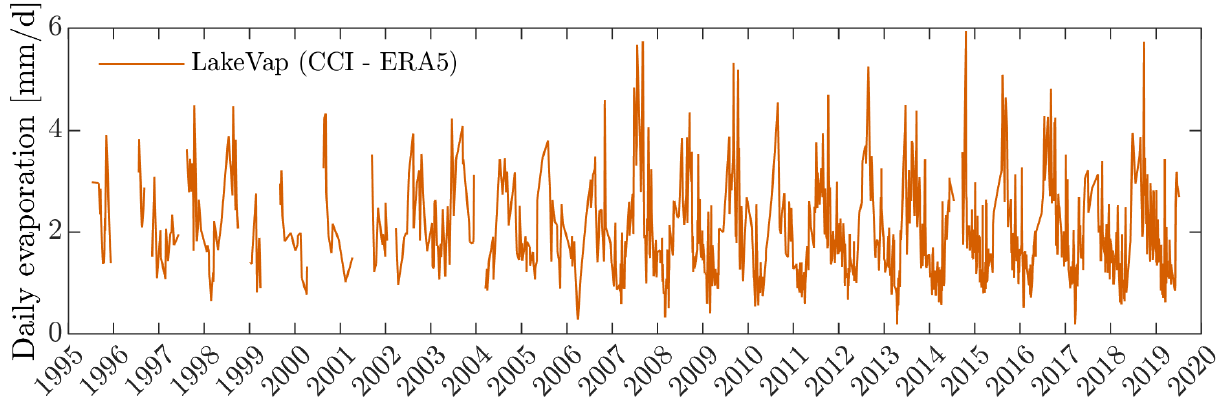
Figure 8. Daily evaporation from Lake Garda estimated with the LakeVap tool fed by CCI-Lakes LSWT maps and ERA5 meteorological data (spatial average from daily evaporation maps). The gaps in the time series highlight when LSWT maps are not available for more than 60 consecutive days.